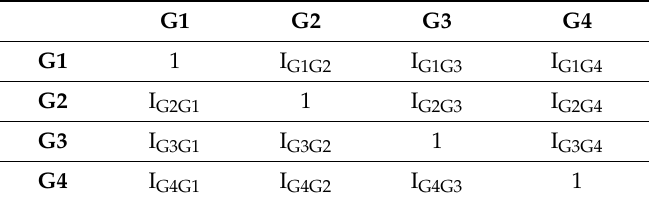
Table 4. Assessing the interdependence of each